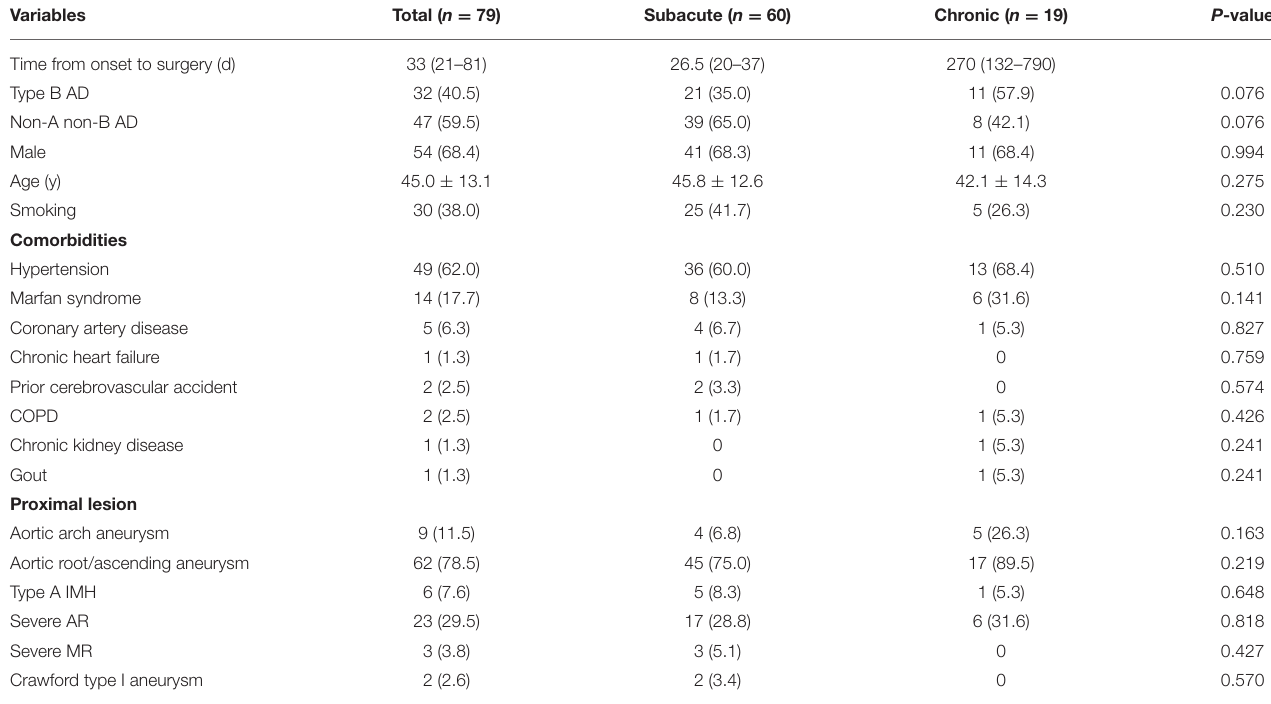
TABLE 1 | Preoperative parameters and comorbidities.